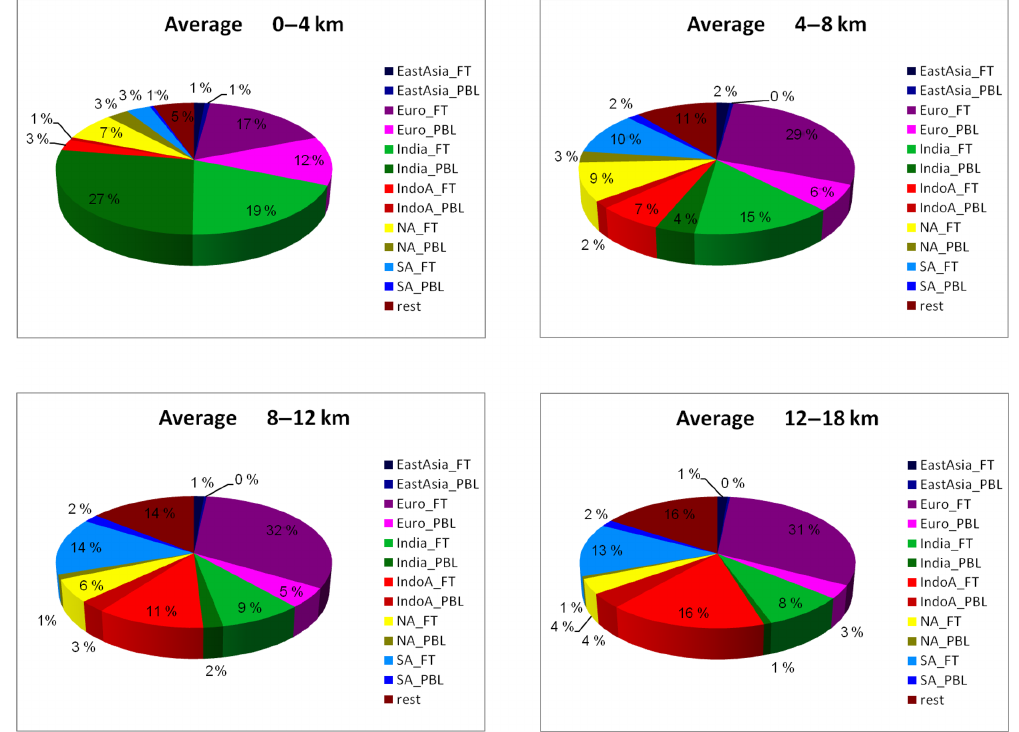
Figure 9. Averaged LRT contributions to the AS tropospheric ozone concentration from different source regions to four atmospheric layers over the AS in April 1997–2007. PBL (planetary boundary layer) is defined as the region from surface to the top of the boundary layer. FT (free troposphere) is defined as extending to the tropopause above the BL.